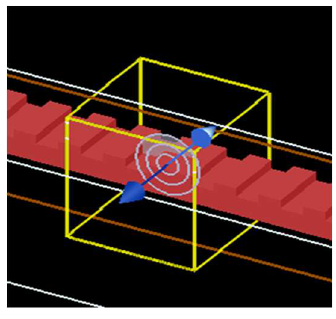
Fig. 7. Electric dipole source surrounded by the transmission